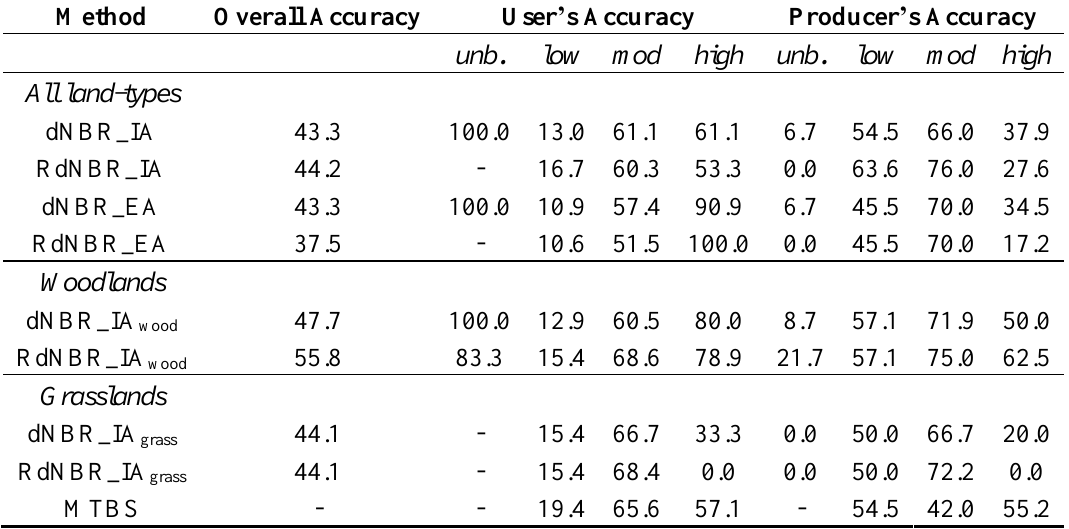
Table 5. Confusion matrices results showing the accuracies of the different methods/models produced. User’s and producer’s accuracies are divided into four burn severity classes; unb. (unburned), low, mod (moderate), and high. Overall accuracy of the MTBS classification method may be inflated since classification of some severity classes (e.g., unburned) did not follow the same